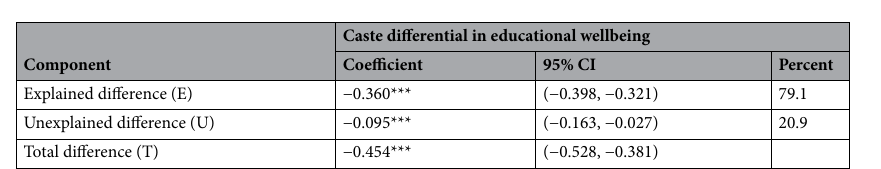
Table 3. Overall Blinder-Oaxaca decomposition of the caste differential in educational wellbeing score of the panel of children during IHDS round-II. (a) CI confidence interval; (b) statistical significance denoted by asterisks where *p-value < 0.1, **p-value < 0.05 and ***p-value <